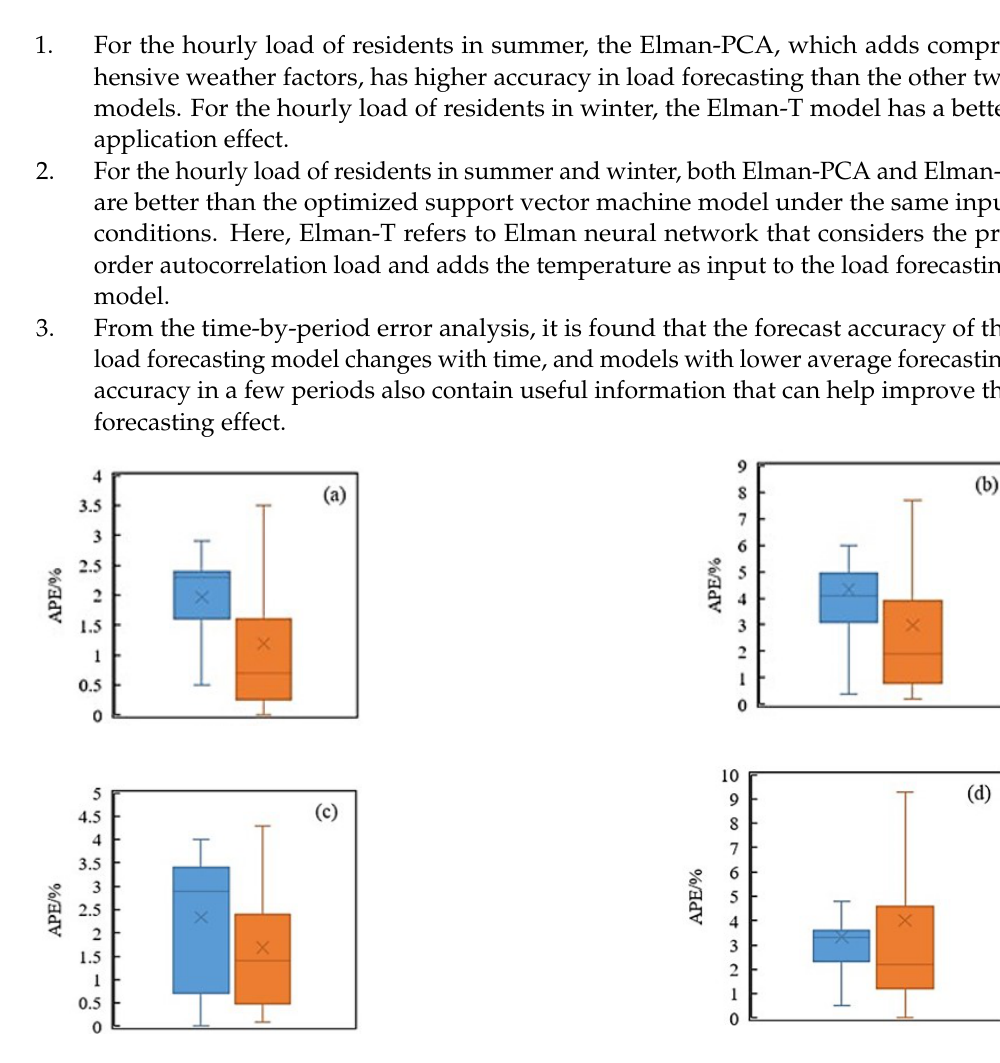
Figure 8. Statistical chart of total load error in four seasons. ( a ); Spring (March 1 to June 3); ( b ) Sum- mer (June 4 to September 3); ( c ) Autumn (September 4 to December 3); ( d ) Winter (February 4 to February 28 of the following